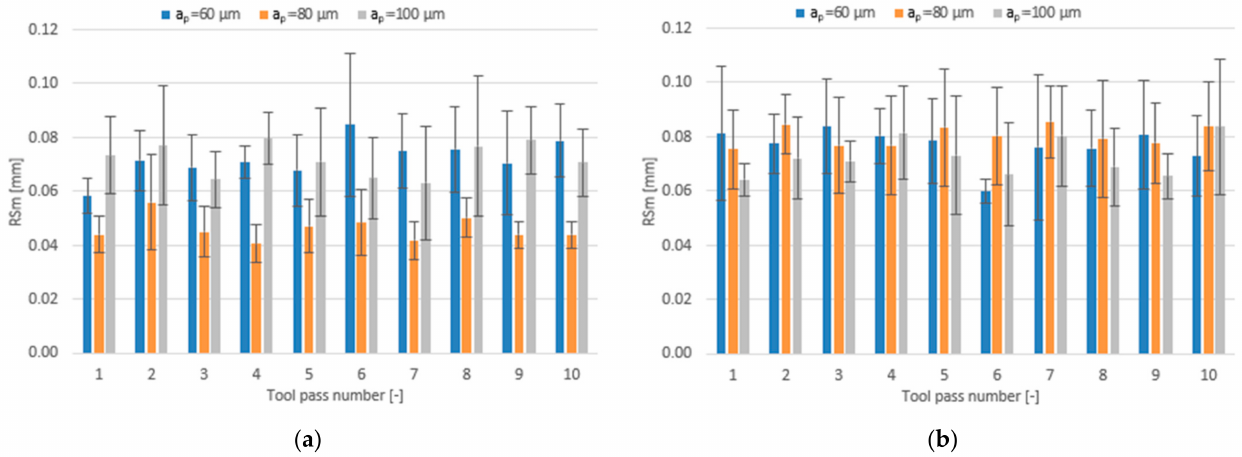
Figure 17. Axial depth of cut a p versus surface roughness parameter RSm in the milling process performed using a tool coated with: ( a ) TiB 2 and ( b ) TiAlN; (v c = 800 m/min; f z = 5 µ